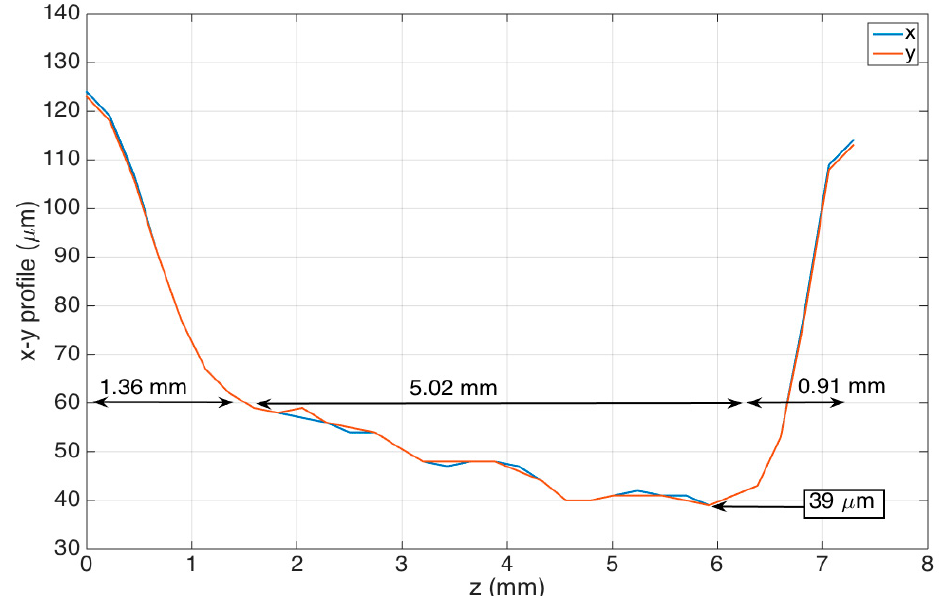
Figure 3. Profilometry of the fabricated stCFBGs, reporting the fiber thickness within the grating region as on x/y directions as a function of the fiber axis z.